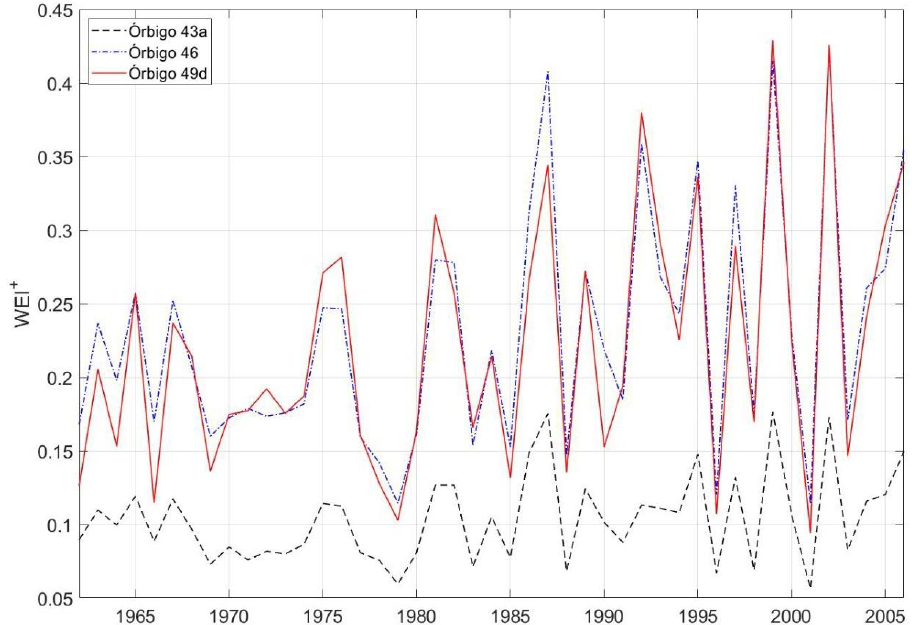
Figure 6. Evolution of the yearly WEI + in three river stretches in the upper (Ó rbigo 43a), middle (Ó rbigo 46) and lower (Ó rbigo 49d) parts of the basin (Figure 3). In Figure 7, the monthly average values of WEI + and the WEI + values during a year with a high level of water stress (2002, Figure 6) are depicted for the three Ó rbigo river stretches previously analyzed (Ó rbigo 43a, Ó rbigo 46 and Ó rbigo 49d). It is observed that the monthly WEI + values are negligible between October and March, whereas in August, the average WEI + is greater than 1.6, 1.85 and 2.45 in the upper, lower and middle stretches of the Ó rbigo River, respectively. These maximum monthly WEI + values in 2002 (lower panel of Figure 6) are equal to 1.67, 3.04 and 3.37, respectively. These WEI + values indicate the high levels of water stress in the summer months in the upper, middle and lower parts of the river basin, as well as the importance and neces- sity of river regulation to satisfy the water demands and environmental constraints during all the months. In fact, the consumed water resources (numerator of Equation 1) in August in the upper, lower and middle stretches of the Ó rbigo River are, on average, more than 1.6, 1.85 and 2.45 times greater than the available water resources (denominator of Equa- tion 1) in this month, respectively. The values of available and consumed water resources are influenced by the environmental flow regimes established in the river stretches, as reported in Section 4.3.